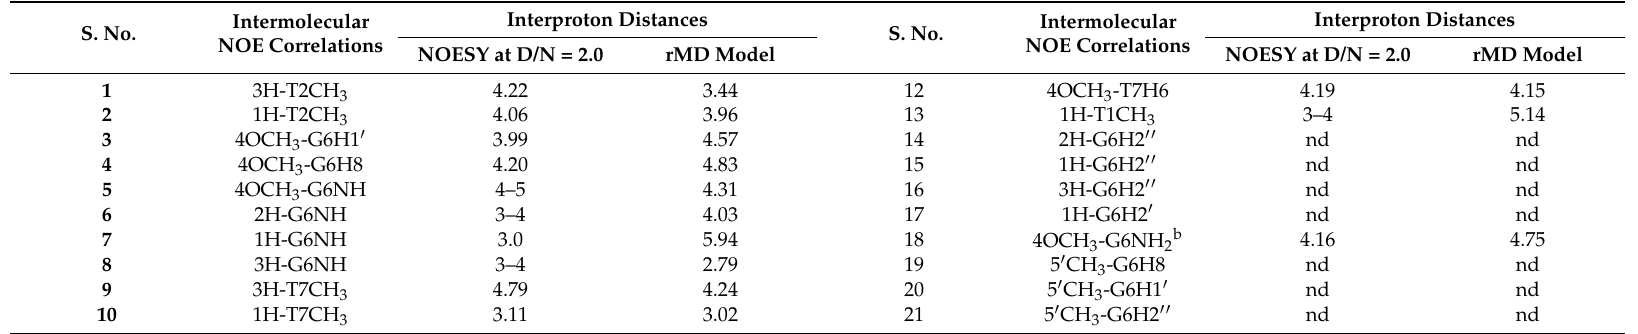
Table 3. Interproton distances (Å) between daunomycin and [d-(TTGGGGT)] 4 obtained from NOE cross-peaks at D/N = 2.0, τ m = 250 ms, at 25 ◦ C and corresponding distances (Å) in rMD model of daunomycin-[d-(TTGGGGT)] 4 complex. nd: not determined. S.